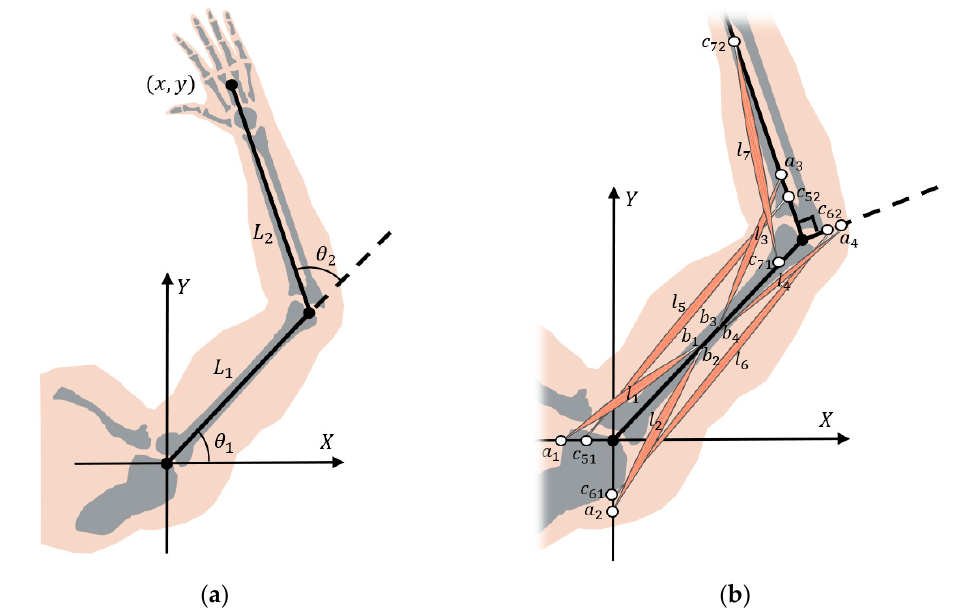
Figure 1. Schematic diagram of the human musculoskeletal arm model: ( a ) a planar kinematic model of the human arm; ( b ) a planar dynamic model of the human musculoskeletal arm.